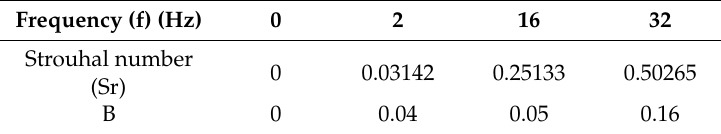
Figure 9. The effect of phase difference between the mainflow and coolant oscillation for M = 0.5, 2 Hz using FLUENT, LES, Smagorinsky–Lilly. Table 4. The B values in Equation (7) as a function of frequency.